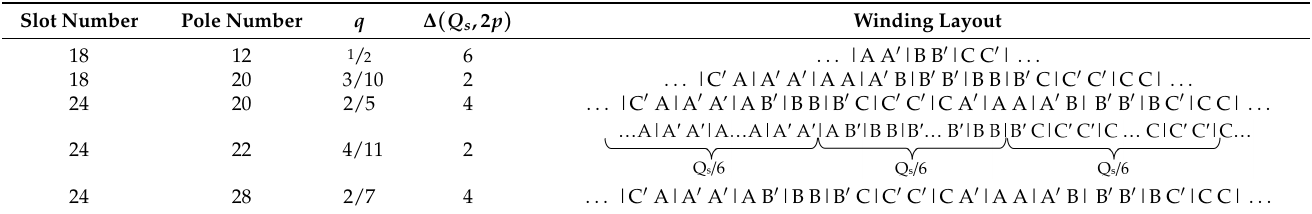
Figure 2. Schematics of selected PMSMs: ( a ) conventional PMSM with non ‐ segmented stator, ( b ) PMSM with modular stator core. Table 2. Selected slot/pole combinations, including their winding layout considering TCW.